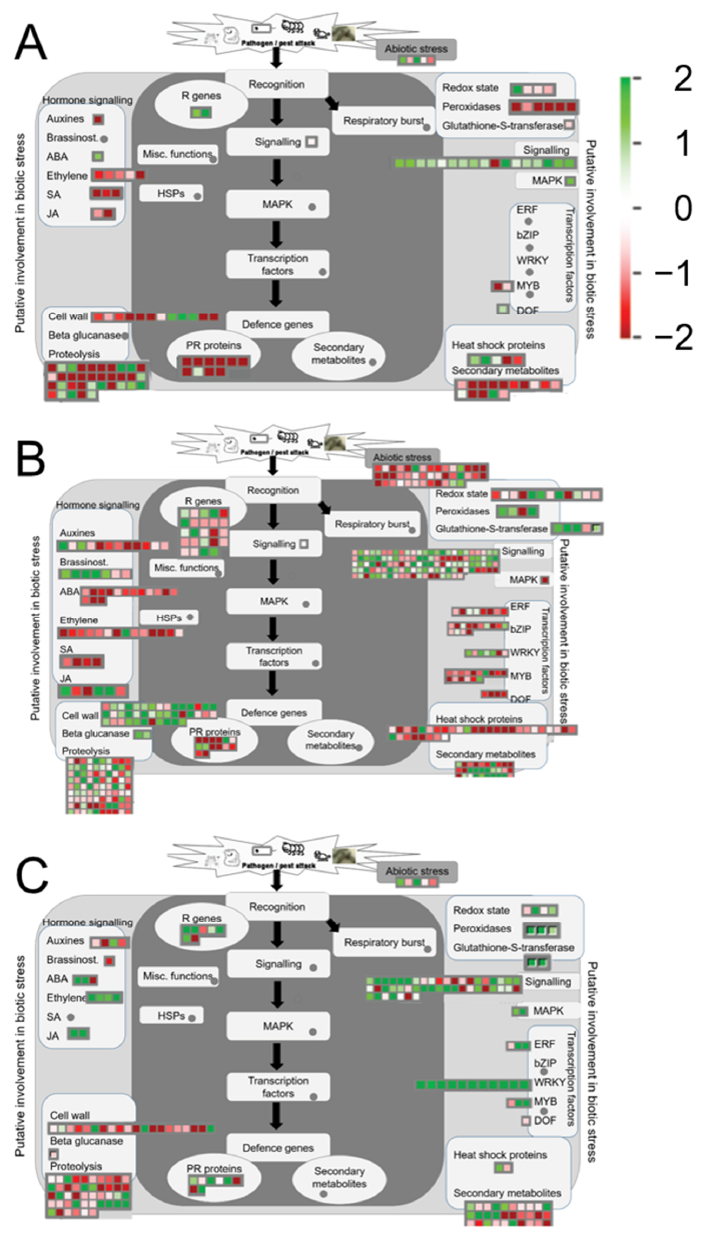
Figure 5. MapMan illustration of DETs belonging to the ‘Biotic stress’ BIN at ( a ) 12 hpi, ( b ) 24 hpi ( c ) 48 hpi. Log2 fold change is indicated as gradient from green (upregulated) to red (downregulated).